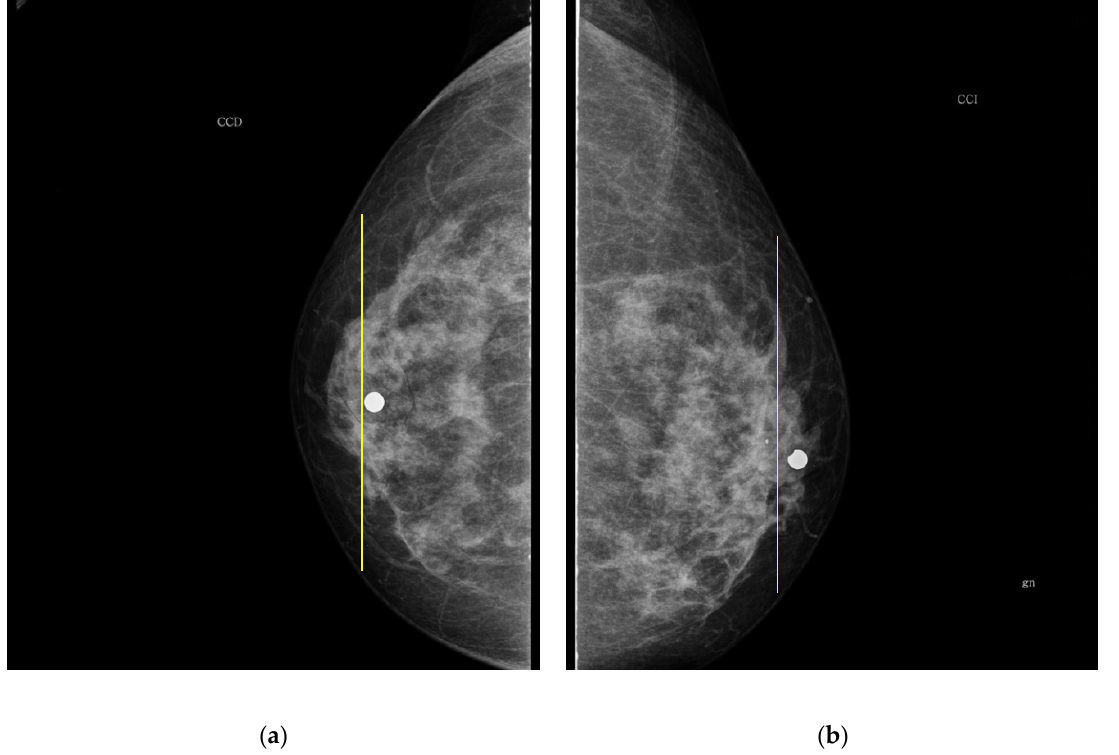
Figure 7. CC mammogram images of participant 1 and relative electrode ring position (yellow vertical line): ( a ) right breast; ( b ) left breast.